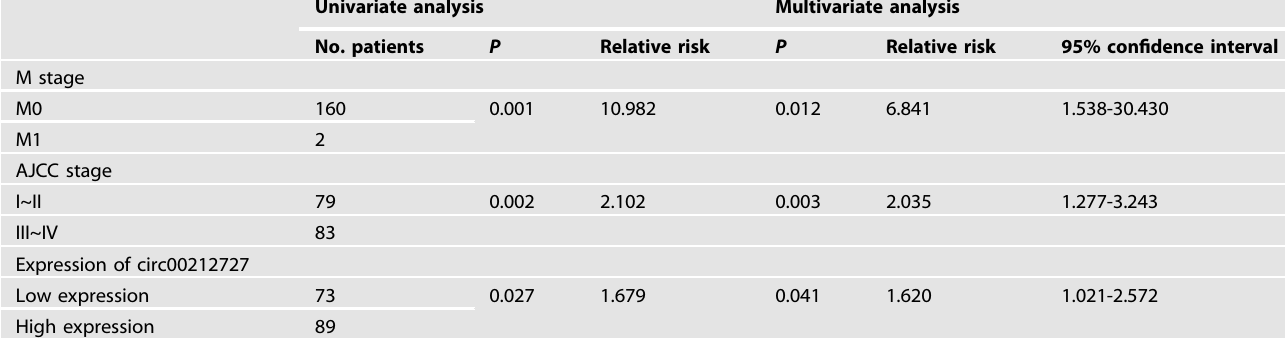
Table 2. Univariate and multivariate analyses of various prognotic parameters in patients with esophageal cancer by cox-regression